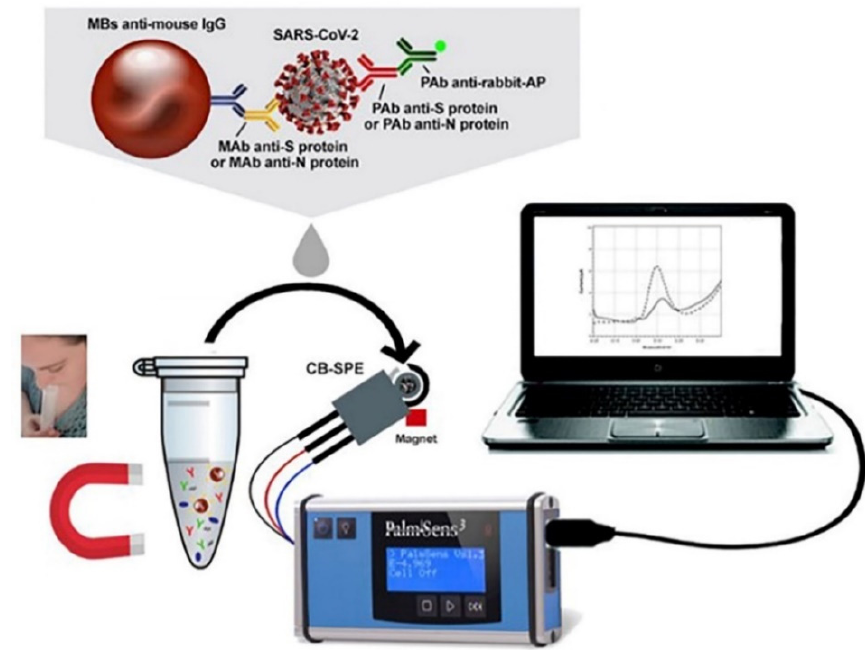
Figure 5. Electrochemical immunosensors for SARS-CoV-2 detection. Immunosensor based on SPE modified with magnetic beads (MBs) for antigen detection. Reproduced with permission from [40]. Copyright 2021,